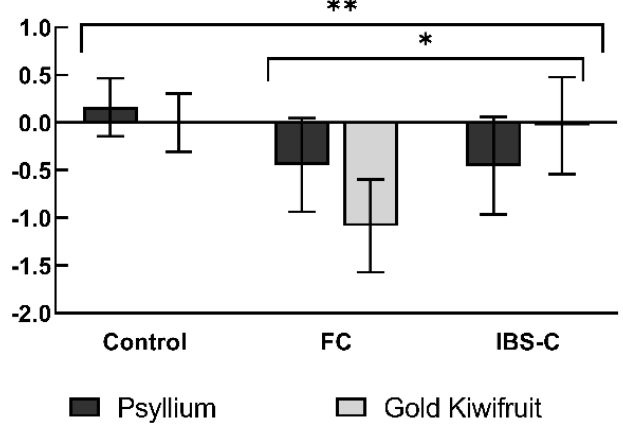
Figure 3. Gastrointestinal Symptom Rating Scale Constipation Domain Scores. Δ -score: median score after subtraction of pre-intervention score from post-intervention = relative shift from baseline. Bars: arithmetic means, error bars: 95% confidence intervals. Positive score = increase in symptom, negative score = decrease in symptom. n = 54. Asterisks indicate statistical significance. ** = Statistical significance as an effect of interventions, p = 0.004; * = Control vs. FC vs. IBS-C, Effects of participant group, p = 0.044. FC, Functional Constipation; IBS-C, Constipation-predominant Irritable Bowel Syndrome. Table 3. Differences in Gastrointestinal Symptom Rating Scale Scores post – pre-intervention.